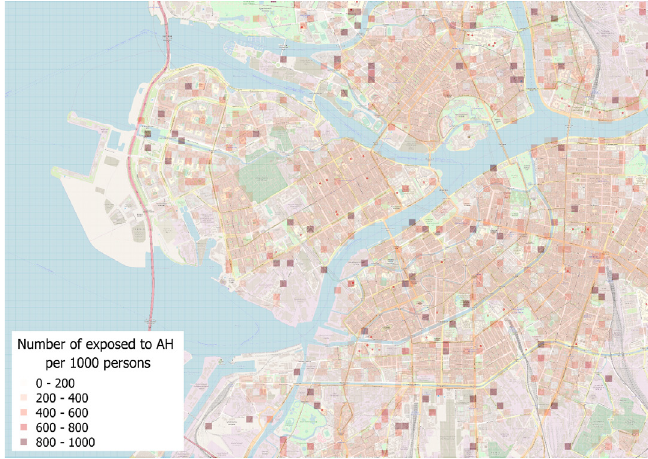
in Python programming language with the libraries numpy , matplotlib , and pandas . The output of the algorithm is a txt-file with the coordinates of the cells and the cell statistics (overall number of individuals, number of AH + individuals). As a final step, we use QGIS open software to draw cells on the map of Saint Petersburg (OpenStreetMap background layer). The result is demonstrated in Fig. 3.